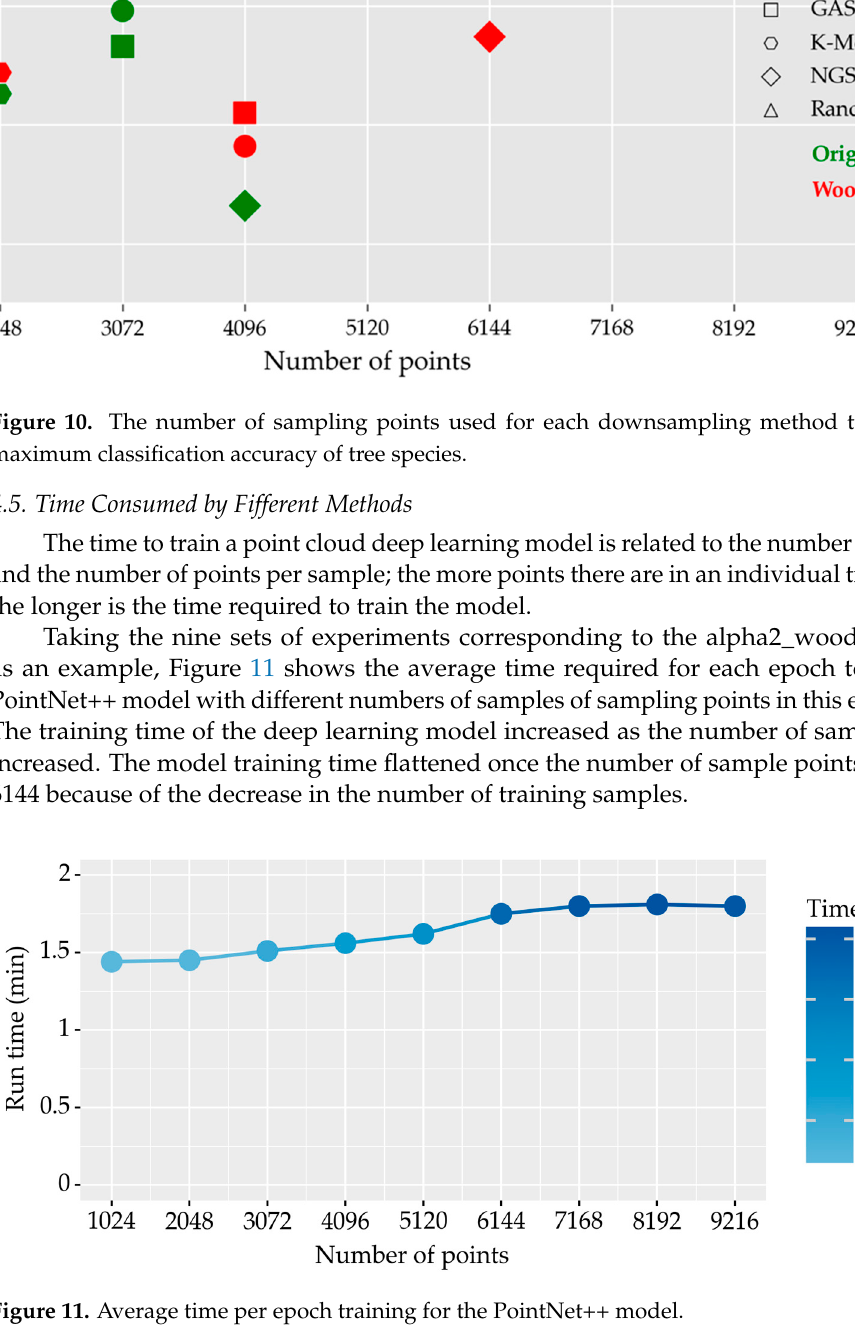
Figure 11. Average time per epoch training for the PointNet++ model.